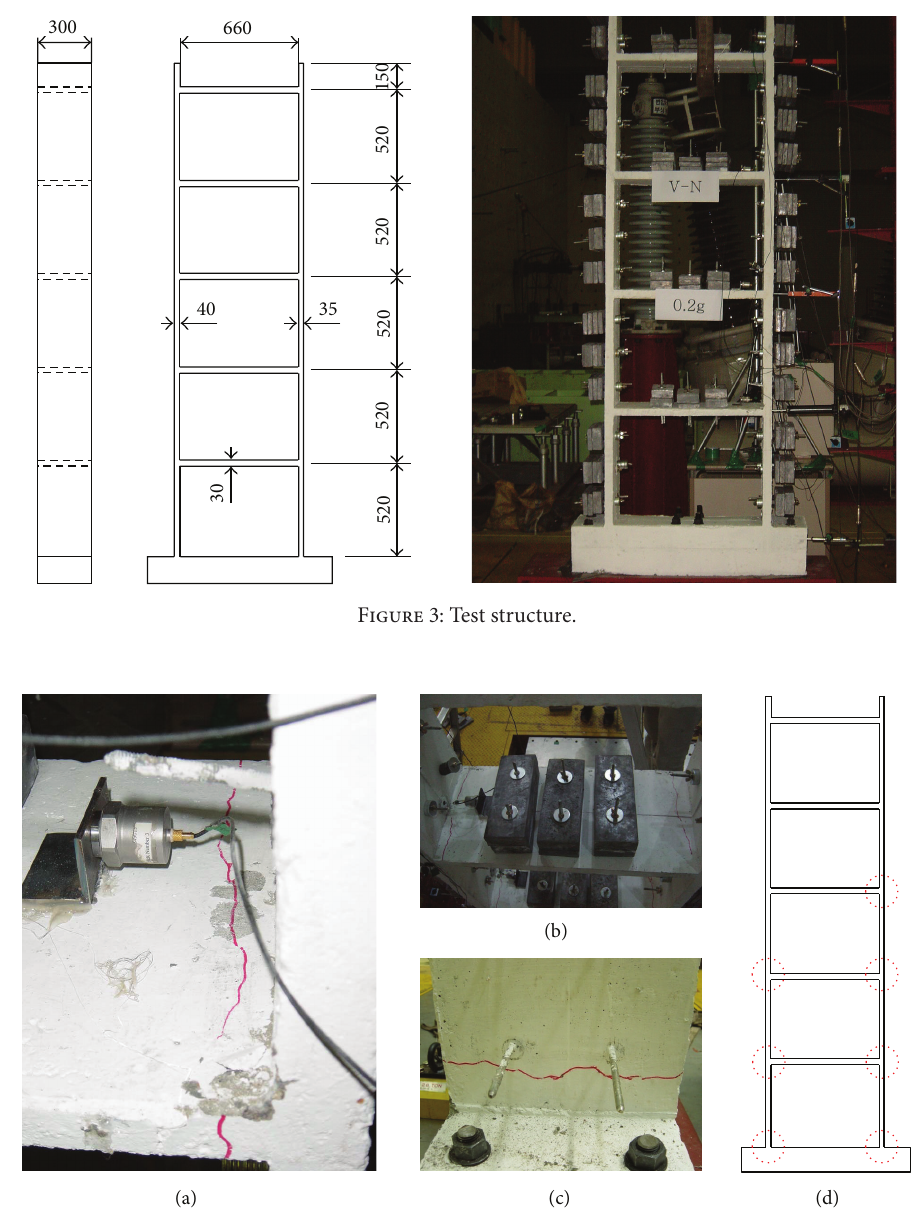
Figure 4: Crack patterns observed after each stage of the tests: (a) the right end of the third-floor slab after 0.20 g shaking, (b) the third- and second-floor slabs after 0.30 g shaking, (c) the base of the first-story wall after 0.50 g shaking, and (d) locations of observed cracks.